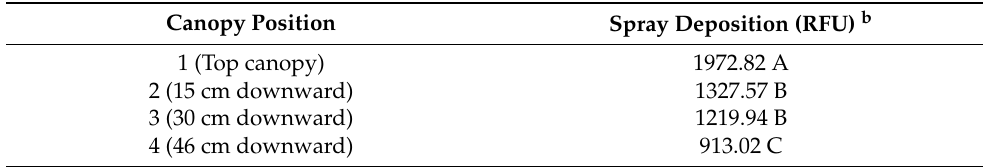
Table 3. Spray deposition a for different cotton canopy levels. Data were pooled over years. Means within a column followed by the same letter are not significantly different ( α ≤ 0.10).